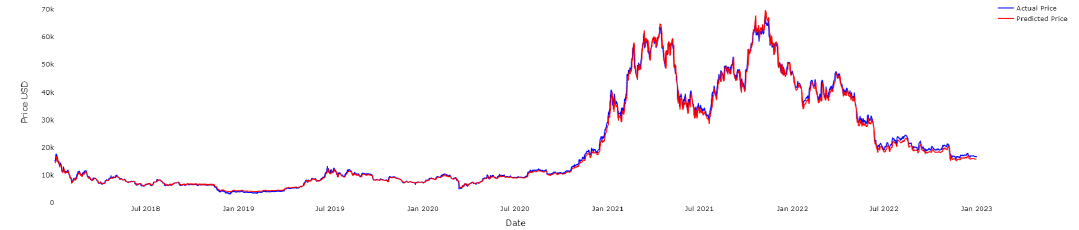
Figure 13. BTC—actual and predicted results using the GRU